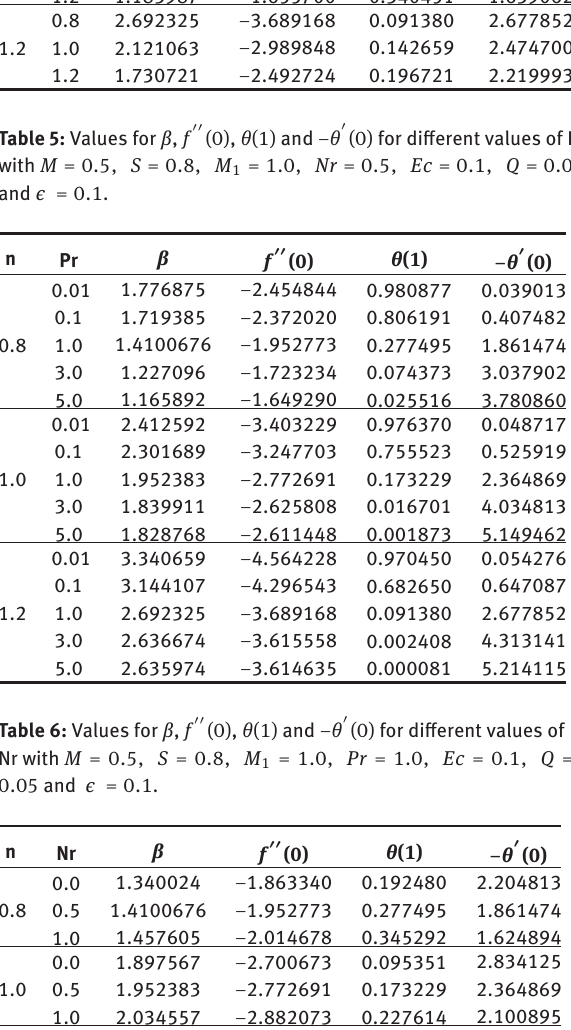
(cid:2) (0) for different values of M